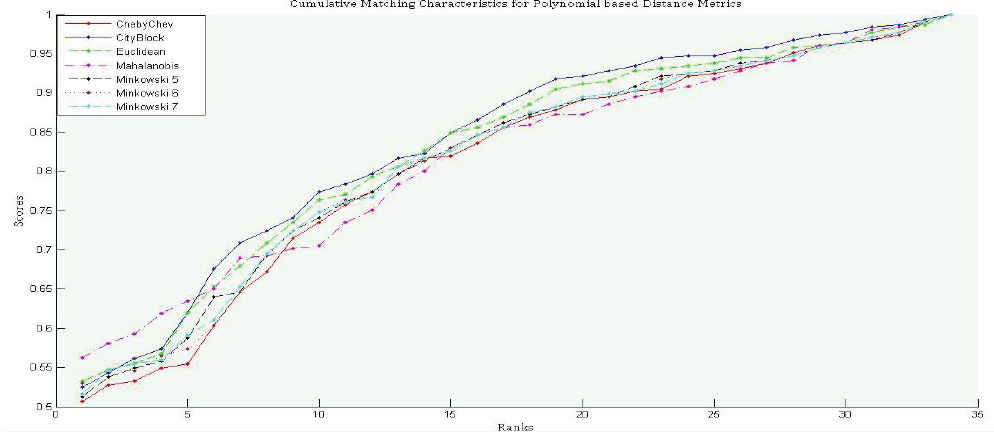
Fig .22. CMC curve for polynomial based Distance based classifiers convex hull area leads the polygon area so the results we obtained are consistent throughout the process.